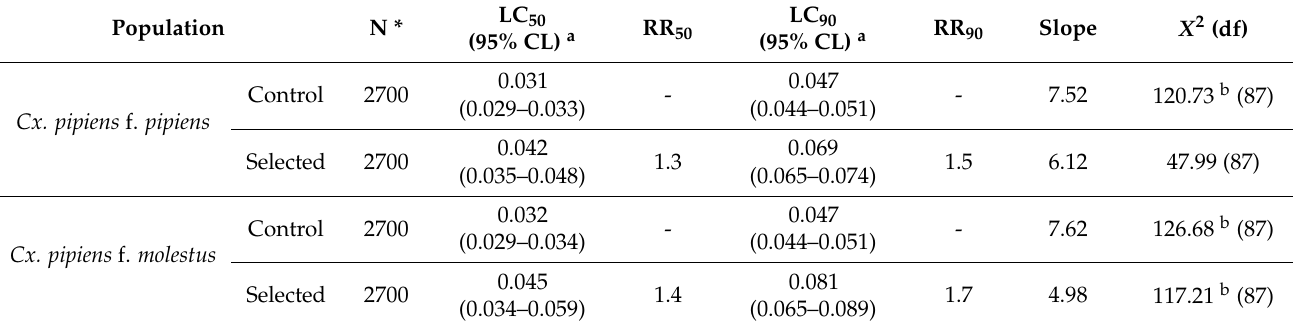
Table 2. Effective doses of Bti against the two forms of Culex pipiens after the selection process for three successive generations by applying fixed doses corresponding to LC 80 of the control